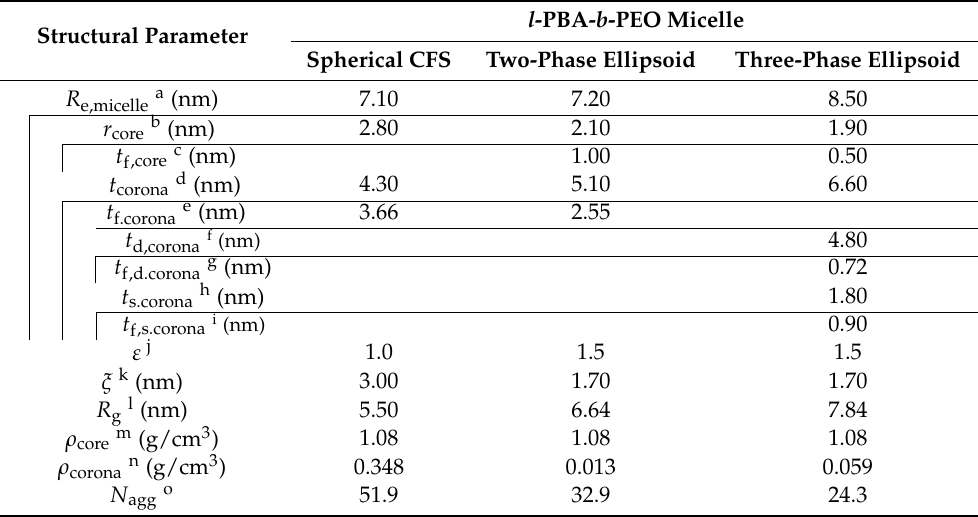
Table 2. Structural parameters of the l -PBA- b -PEO micelle obtained from the quantitative analysis of scattering data with various model